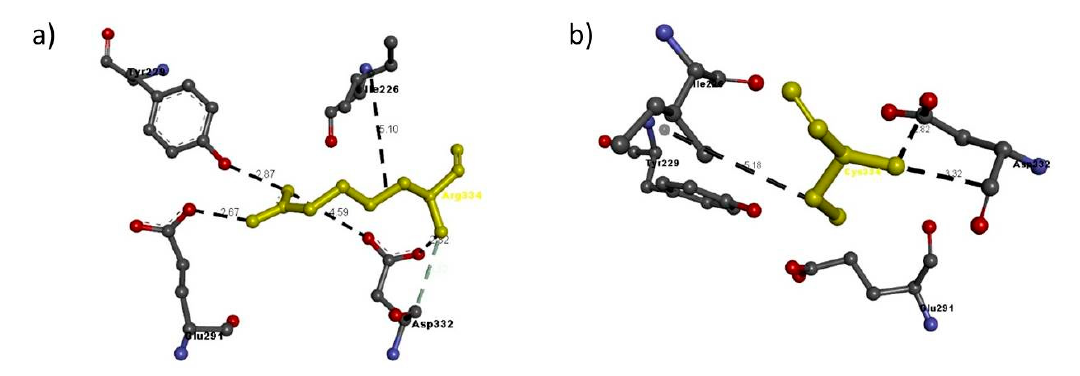
Figure 9. Molecular interactions of ( a ) Arg334 and ( b ) Cys334 (in yellow) of the modeled NRP2 protein with adjacent